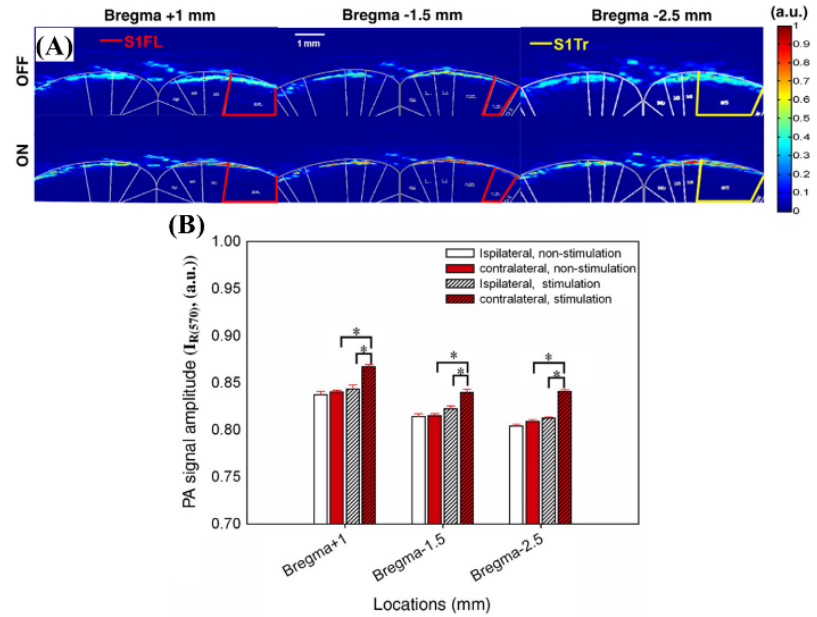
Figure 23. ( A ) In vivo I R (570) images registered and fused with the rat atlas at the positions of bregma +1, −1.5, and −2.5 mm for stimulation -OFF (upper panels) and stimulation-ON (lower panels). ( B ) Quantitative analysis of the I R (570) signal changes in the bilateral ROIs between the stimulation-ON and -OFF conditions. Reprinted from Liao et al . , Neuroimage, 2010, 52, 2: 562–570 [40],